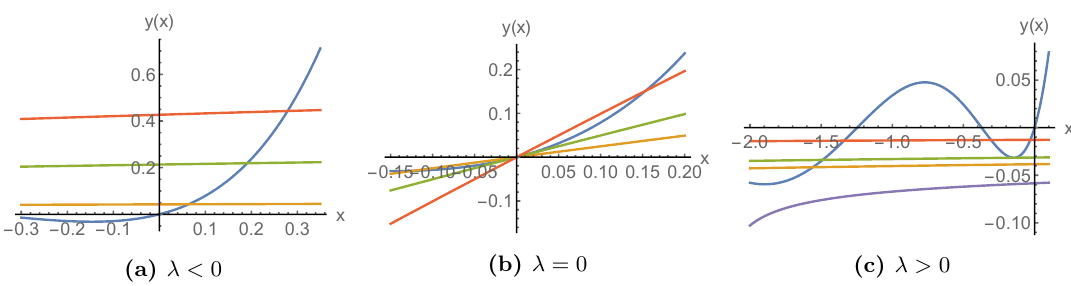
√ √ Figure 5. Plot of xI 1 (2 π x ) / (2 π ) (blue) and − Ke − S 0 f λ ( x ) (other colors) for different λ . The largest intersection point gives zero point energy E 0 . (a) yellow, green and red means increasing K and E 0 moves rightward as K increases; (b) yellow is K < K = is K > K = . E 0 = 0 when K ≤ K = , and E 0 > 0 when K > K = cr cr